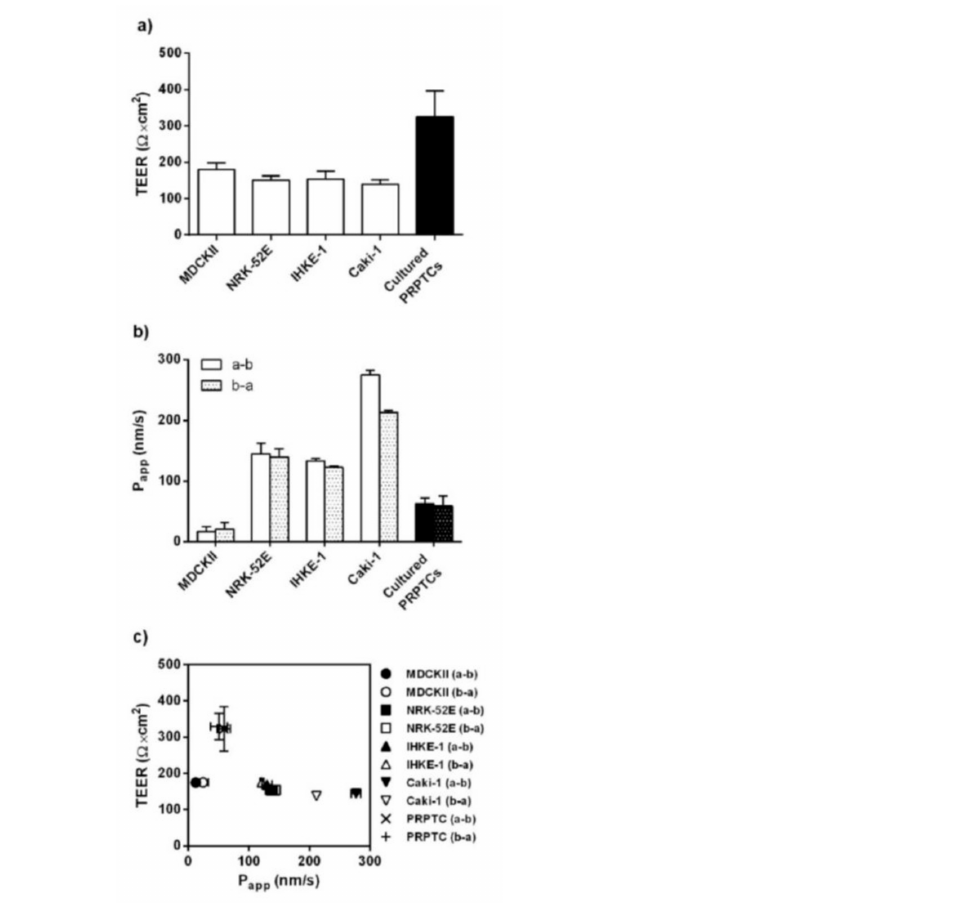
Figure 8. TEER values ( a ) and apparent permeability coefficients (P app ) of [ 14 C]-mannitol ( b ) in the renal cell lines MDCKII, NRK-52E, IHKE-1 and Caki-1 and in cultured PRPTCs. All cells were cultured on filter inserts for 5 days under standard conditions. For determination of P app values, cell monolayers were incubated with 600 µ M [ 14 C]-mannitol (12.5 KBq/mL) for 120 min. Each bar represents the mean ± SD of 3 different sets of experiments. A correlation plot of TEER and P app values is shown in ( c